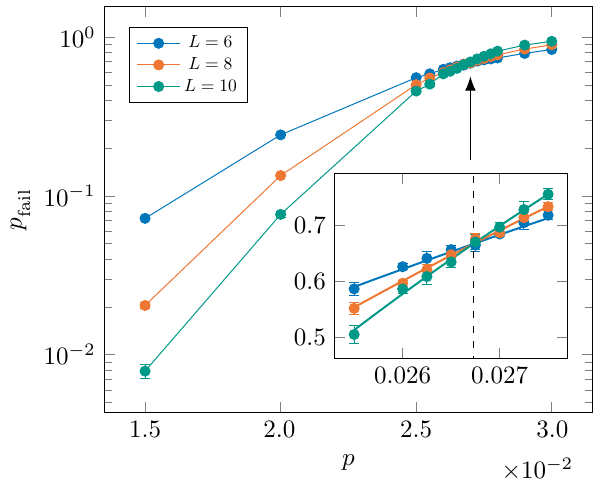
FIG. 4. Threshold plot for the family of nontopological 3D product codes listed in Table III after 16 rounds of single-shot error correction using the BP+OSD × 2 decoder. The simulation results suggest a threshold at 2.7%. The error bars show the 95% (cid:13) confidence intervals p fail = ˆ p fail ± 1.96 p fail ( 1 − p fail )/η , where η is the number of Monte Carlo